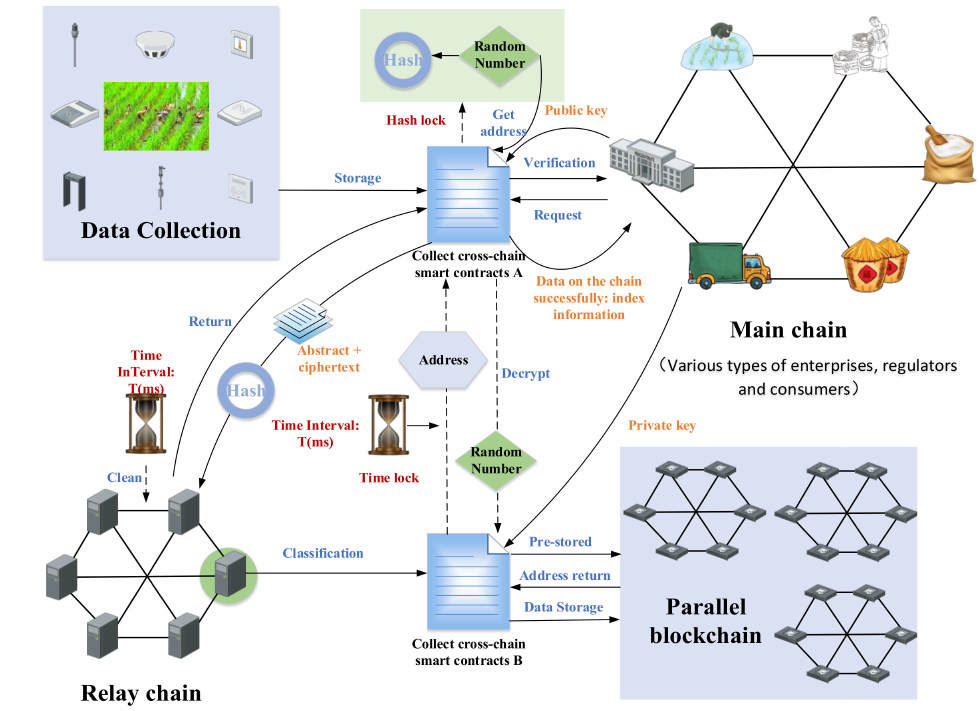
Figure 3. Schematic diagram of collection cross-chain